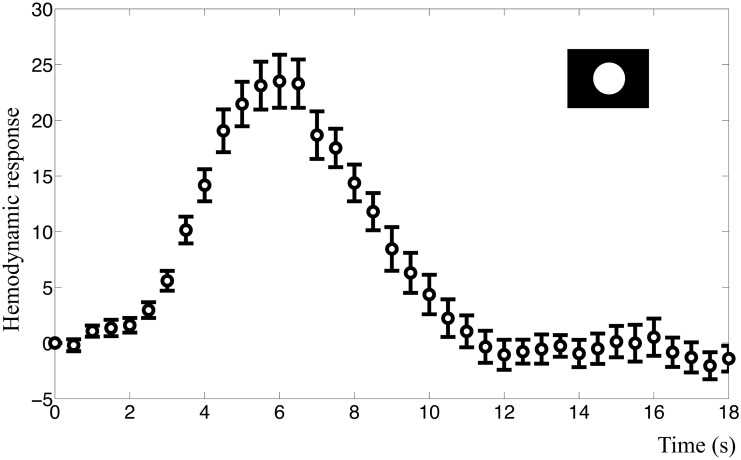
BOLD response in the visual cortex.The figure shows the mean BOLD response and standard error for the primary visual stimulus of the intensity experiment. This time course was used as estimation data when the models were fitted. The y-axis represents normalized MR signal in arbitrary units.